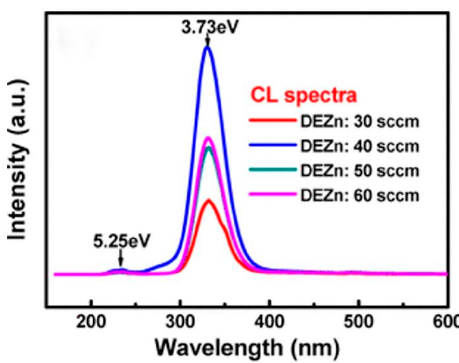
Figure 19. CL spectra of ZnGa 2 O 4 films prepared at the DEZn flow rates of 30 − 60 sccm [76] (with copyright permission from American Chemical Society, 2020).